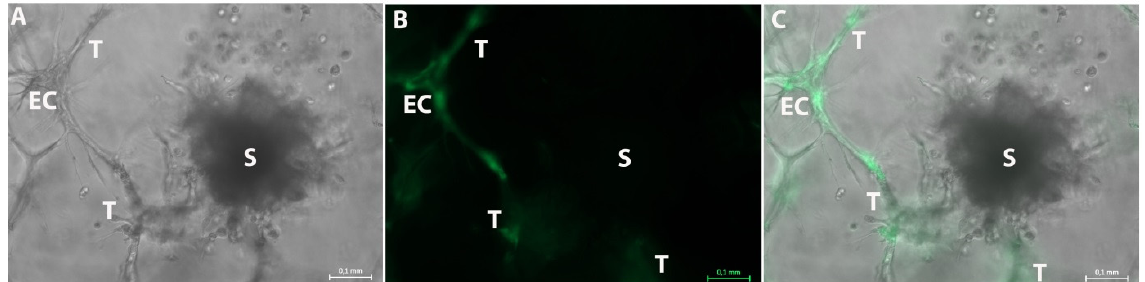
Figure 7. Representative photographs of the 3D tumor-stroma model with GFP transfected HUVEC and tumor spheroids of untransfected H838 tumor cells on day 20. ( A ): Brightfield picture shows a spheroid (S) and an endothelial cell network (EC). The ECs form several tubule-like structures (T) in all directions. ( B ): GFP fluorescence photo of A also shows the GFP-positive endothelial cell (EC) within the tubule-like structures (T). The spheroid (S) is GFP-negative. ( C ): Merged picture of ( A , B ). The GFP-negative spheroid (S) and the GFP-positive endothelial cell (EC) with the tubule-like structures (T) can be observed. These structures extend into all directions. Measuring bar: 100 µm.